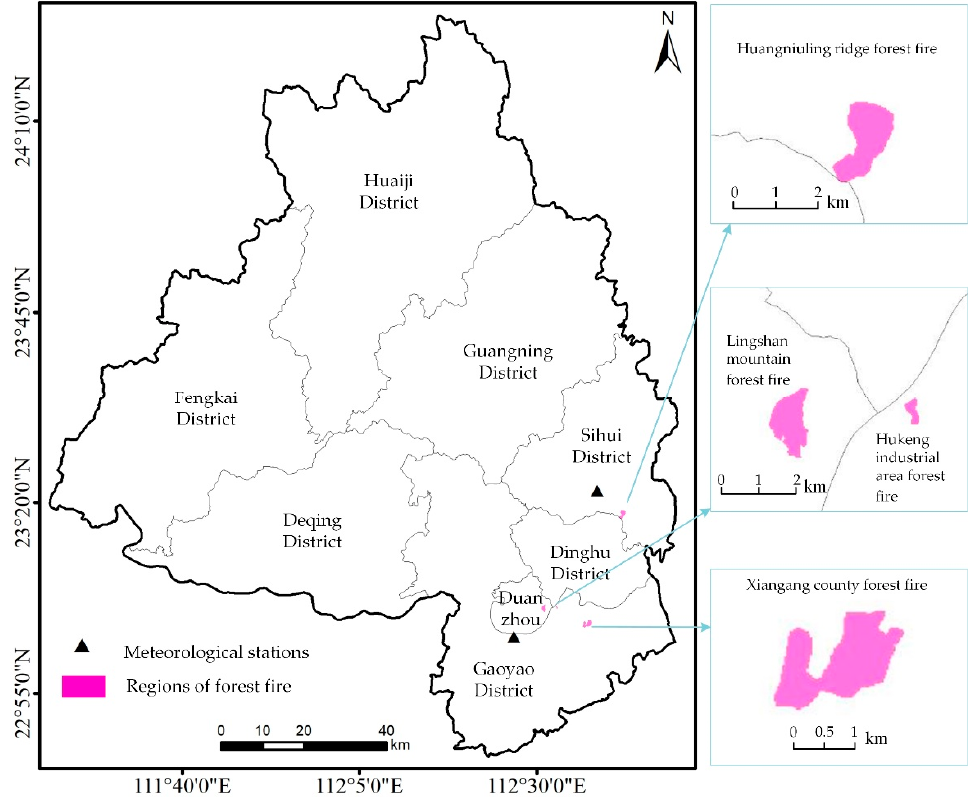
Figure 1. Study area and the four forest fire events in 2020 and 2021.